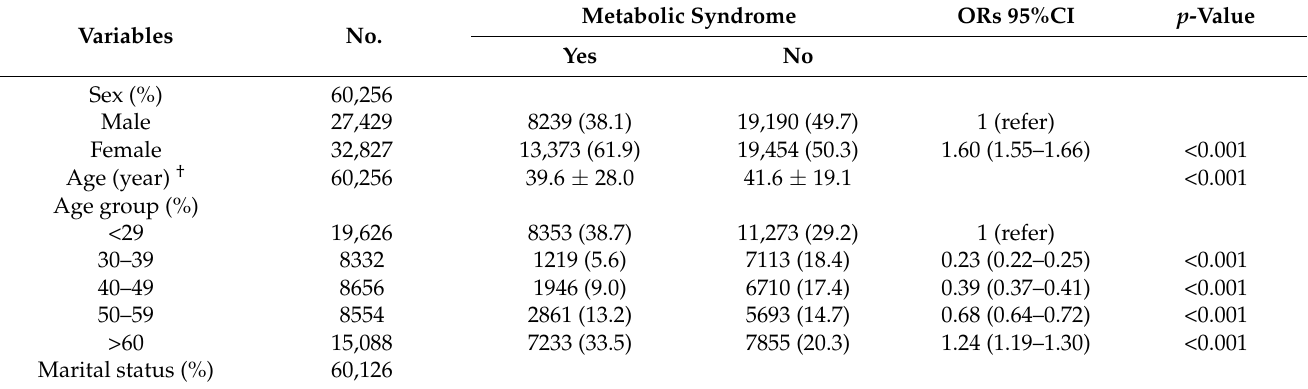
Table 1. Demographic distribution of participants by metabolic